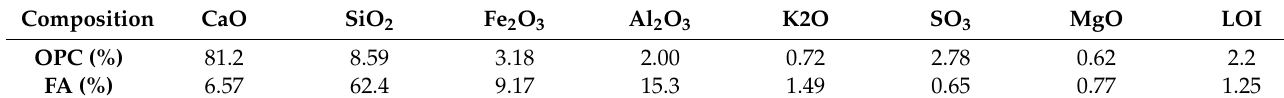
Table 1. Oxide composition of the OPC and FA.